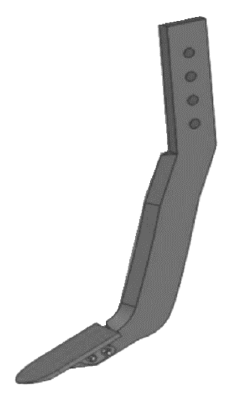
Figure 3: Chisel